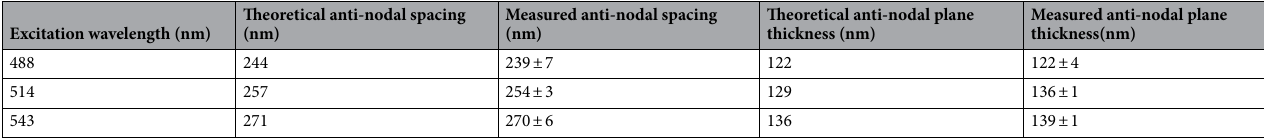
Table 1. Theoretical and measured anti-nodal plane thicknesses and separations for the excitation wavelengths used to image the lens specimen coated with DiI. The measured values are taken from the data shown in Fig. 2(E). The theoretical values of anti-nodal spacing and anti-nodal plane thickness (FWHM) were taken using λ/2n and λ/4n respectively, with λ being the excitation wavelength and a refractive index of n =